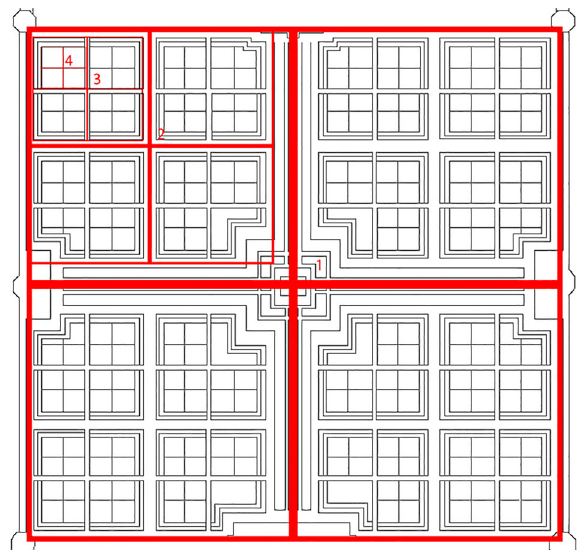
Fig. 8 Taj Mahal analysis. By considering the basic unit as a square divided by a right-angle cross, the global design is the result of 4 repetitions at increasingly larger scales.